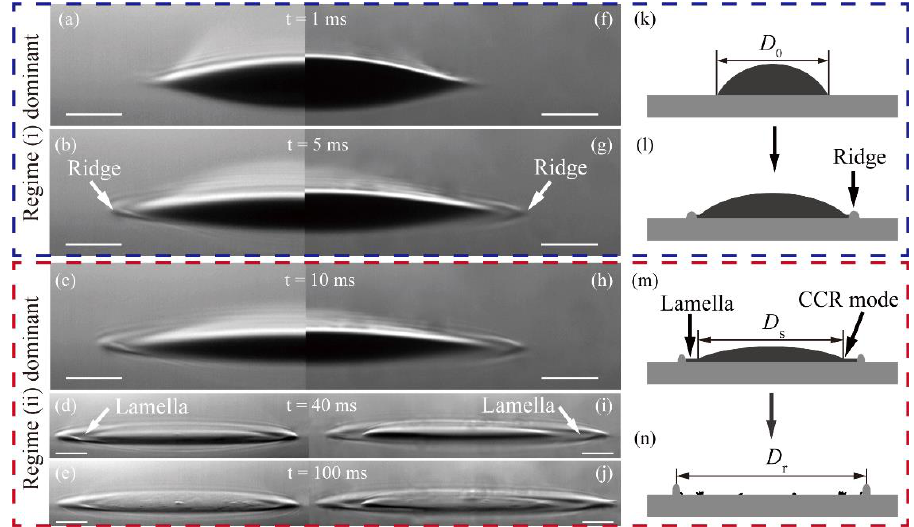
Figure 4. The sequence of events from a CNT droplet’s contact with different films to evaporation. (( a – e ), left) The film was preprocessed at 55 °C for 9 min. (( f – j ), right) The film was preprocessed at 65 °C for 9 min. ( k – n ) Schematic of the spreading and evaporation process of a single CNT droplet. All scale bars are 30 μm in ( a – j ).